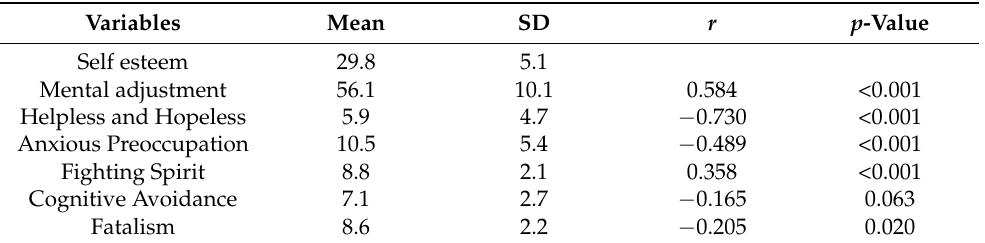
Table 2. Correlation of self-esteem, mental adjustment, and its dimensions among patients with breast cancer ( n =